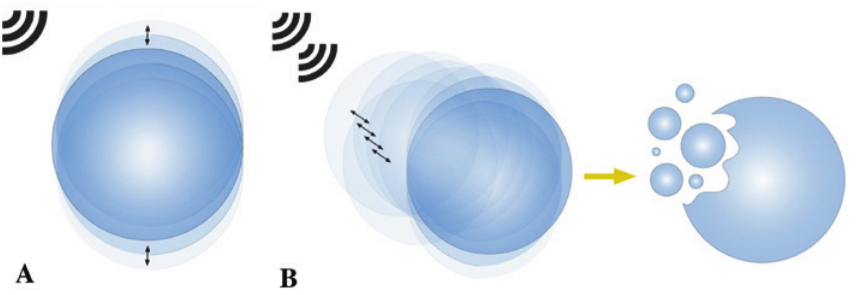
Figure 9: Stable and internal cavitation. (A) Stable cavitation: bubble oscillations due to low power US pulses, which are